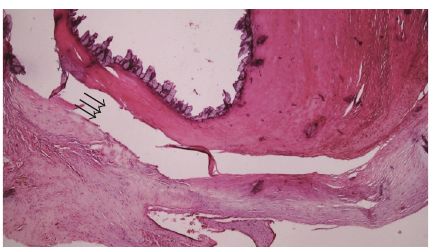
Figure 3: Histological examination showed dense calcification (shredded due to no decalcification) (arrows) in a background of amorphous degenerating fibrinous material (hematoxylin and eosin stain; ×